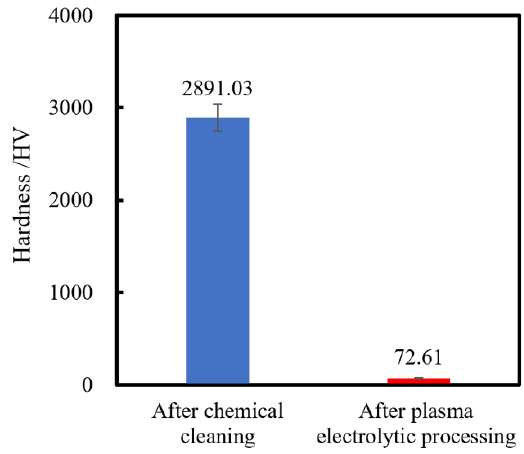
Figure 5. Hardness of SiC measured by Micro Vickers hardness tester.